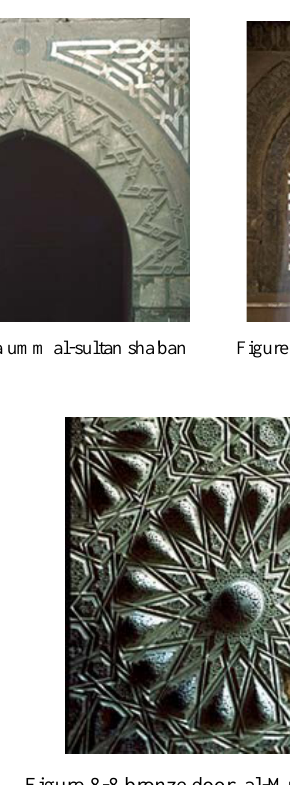
Figure 8-1 Ibn Tulun mosque; minbar, woodwork Figure 8-2 Al-Nasir mosque minbar, woodwork  Islamic geometric patterns stonework